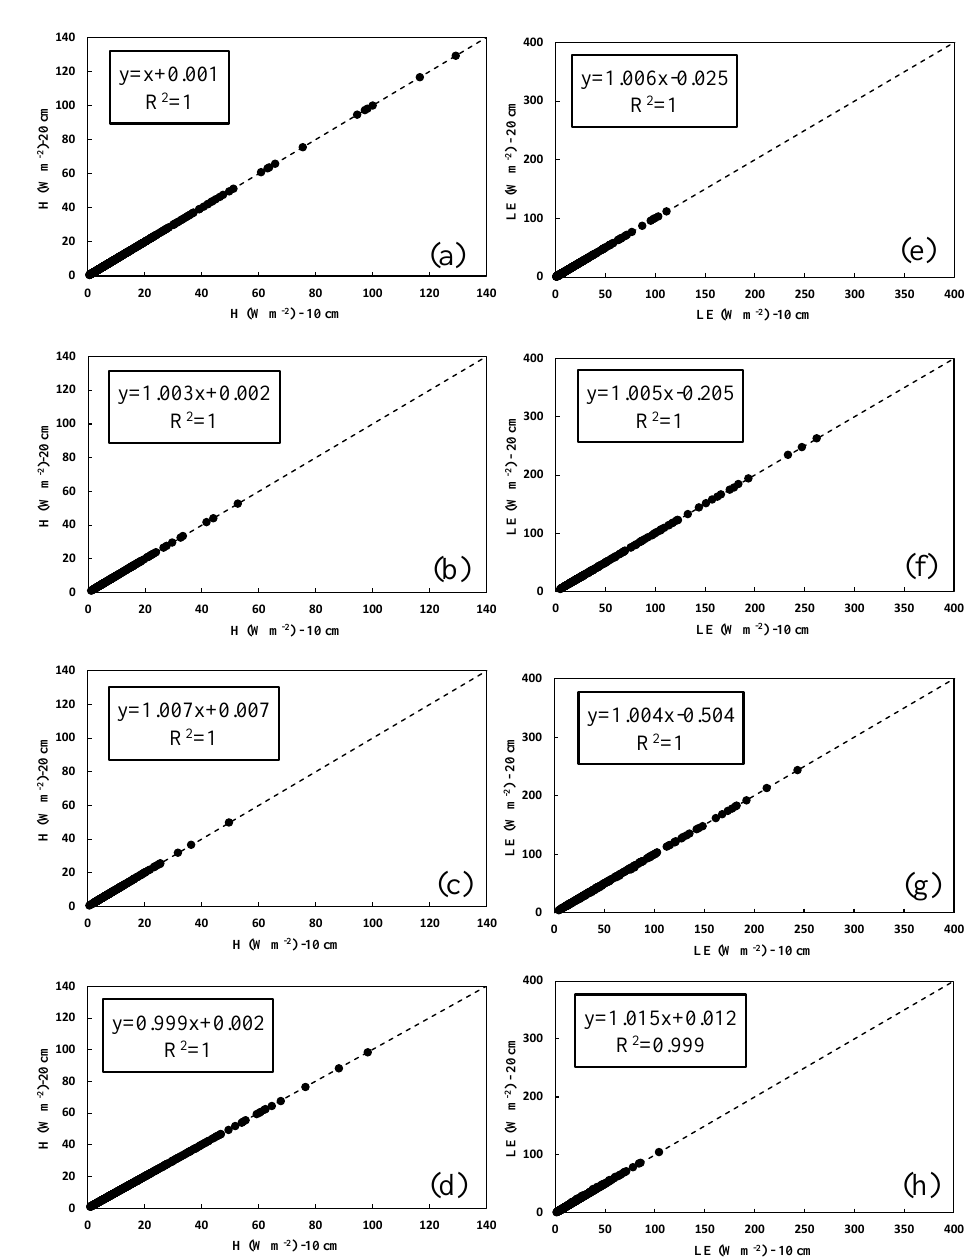
Figure 5. Comparison of the estimated results of H and LE between using water temperature at depth of 10 and 20cm instead of lake water surface temperature in January and February, 2013 (a, e) , May and June, 2013 (b, f) , July and August, 2014 (c, g) , and November and December, 2012 (d, h) with the proposed linearized β